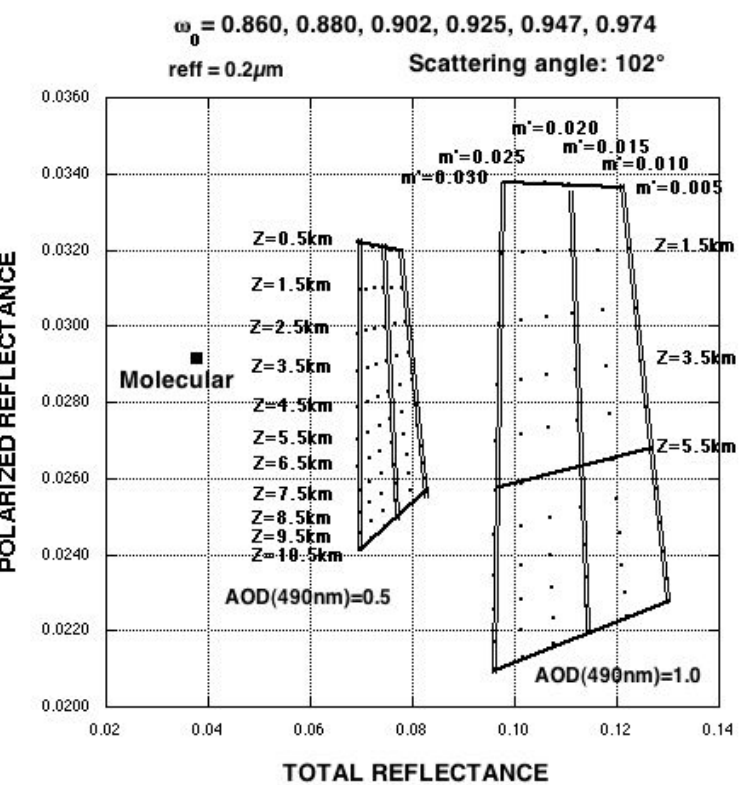
Fig. 3. Scatter plot of the total and polarized reflectance for a number of radiative transfert simulations involving aerosols layers of different optical depth [0, 0.5, 1], altitude [0.5 to 10.5km by step of 1km] and absorption (quantified by the imaginary part of the refractive index: 0.005 to 0.03 by step of 0.005). The optical depth of 0 corresponds to a pure molecular atmosphere and is shown as a reference. For the two other aerosol optical depths, the single solide lines show the reflectance/polarized reflectance trajectories for constant layer altitude, while the double lines are the same for a constant refractive index. Observation geometry is for a scattering angle of 102 ◦ , and the aerosol model has a fine mode effective radius of